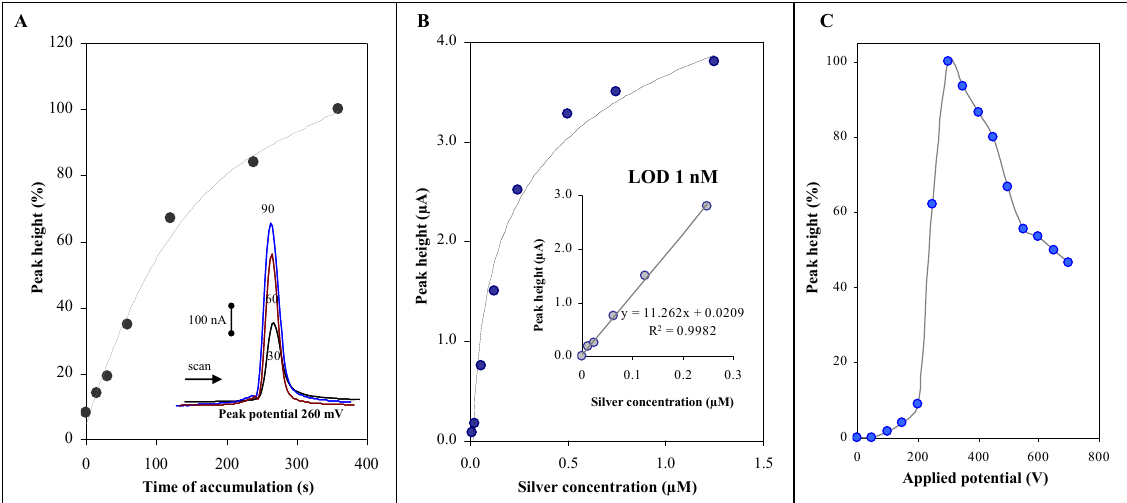
Figure 4. Carbon tip working electrode. (A) Dependence of peak height of silver(I) ions (1 µM) on the accumulation time measured at 0 V; in inset: DP voltammograms measured at accumulation times 30, 60 and 90 s. (B and inset) Dependences of peak height on silver(I) ions concentration (accumulation time 240 s, accumulation potential 0 V). (C) Hydrodynamic voltammogram of silver(I) ions. Flow rate of 0.2 M acetate buffer (pH 5.0) was 0.5 mL/min.